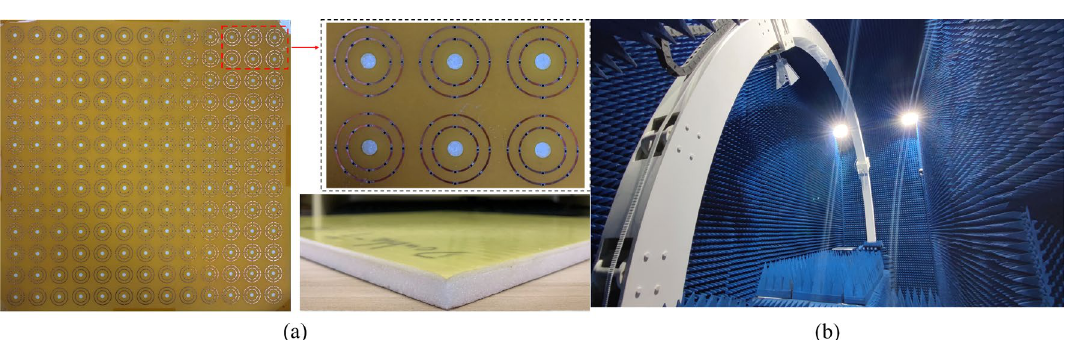
Figure 9. Photograph of the fabricated CA absorber prototype. ( a ) Top view of the fabricated CA sheet, Specific view of unit cell, Perspective view of the fabricated CA absorber prototype. ( b ) Measurement setup for |S 11